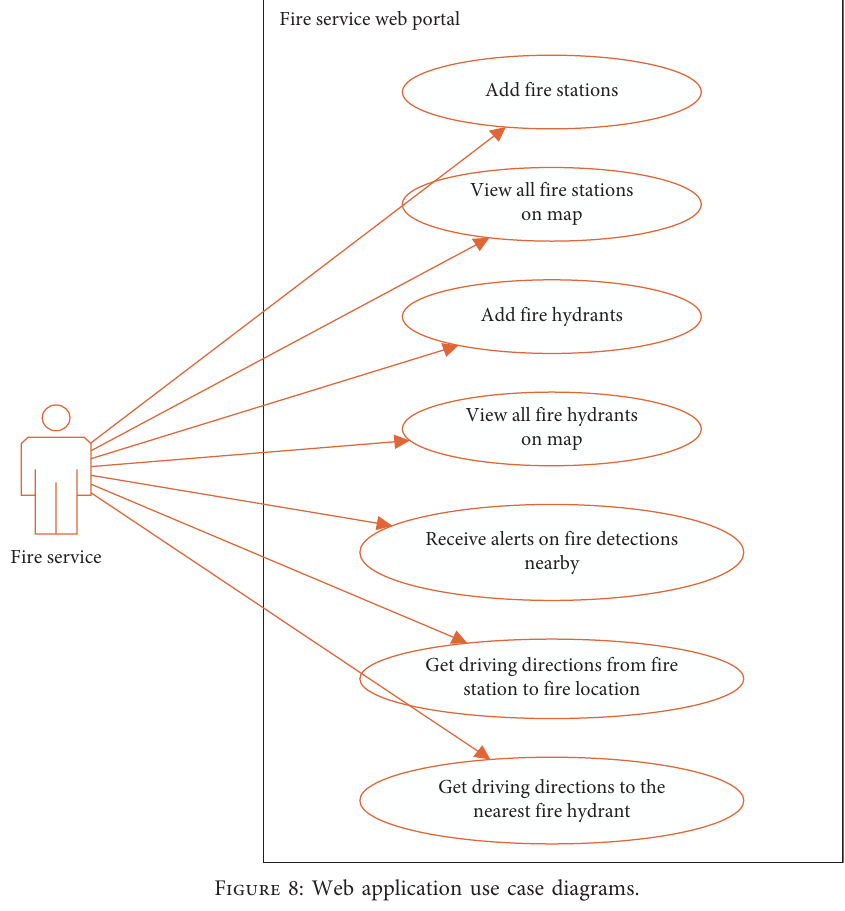
Figure 8: Web application use case diagrams.